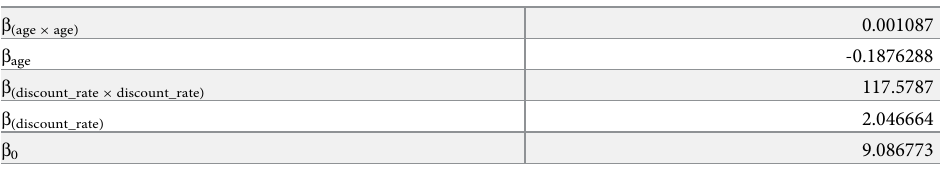
Table 2. Results of final meta-model.